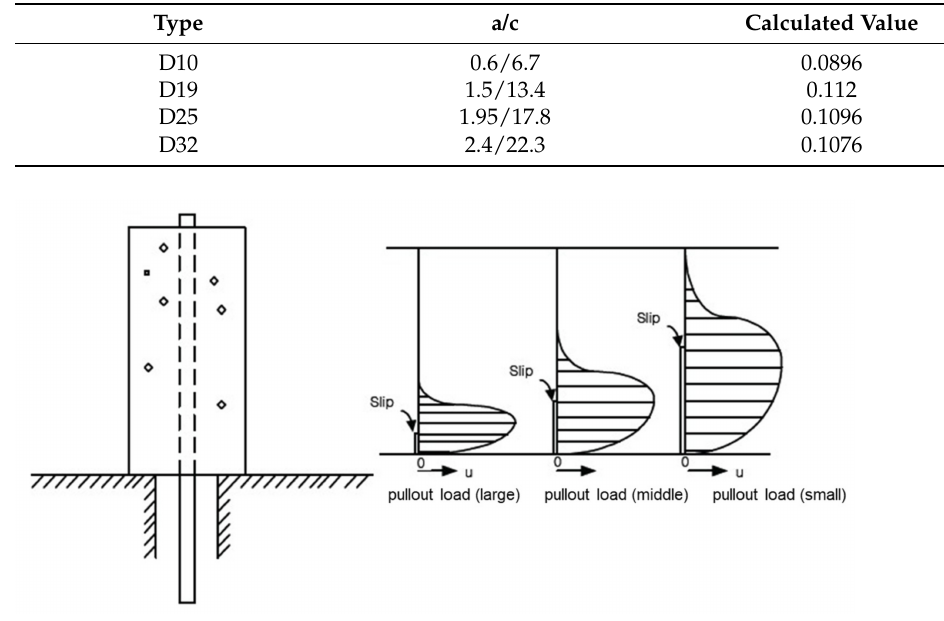
Figure 15. Adhesive tensile test and distribution of adhesive stress